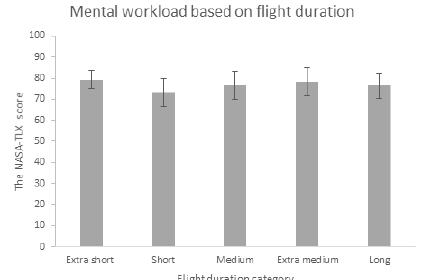
Figure 2. Mental workload on flight